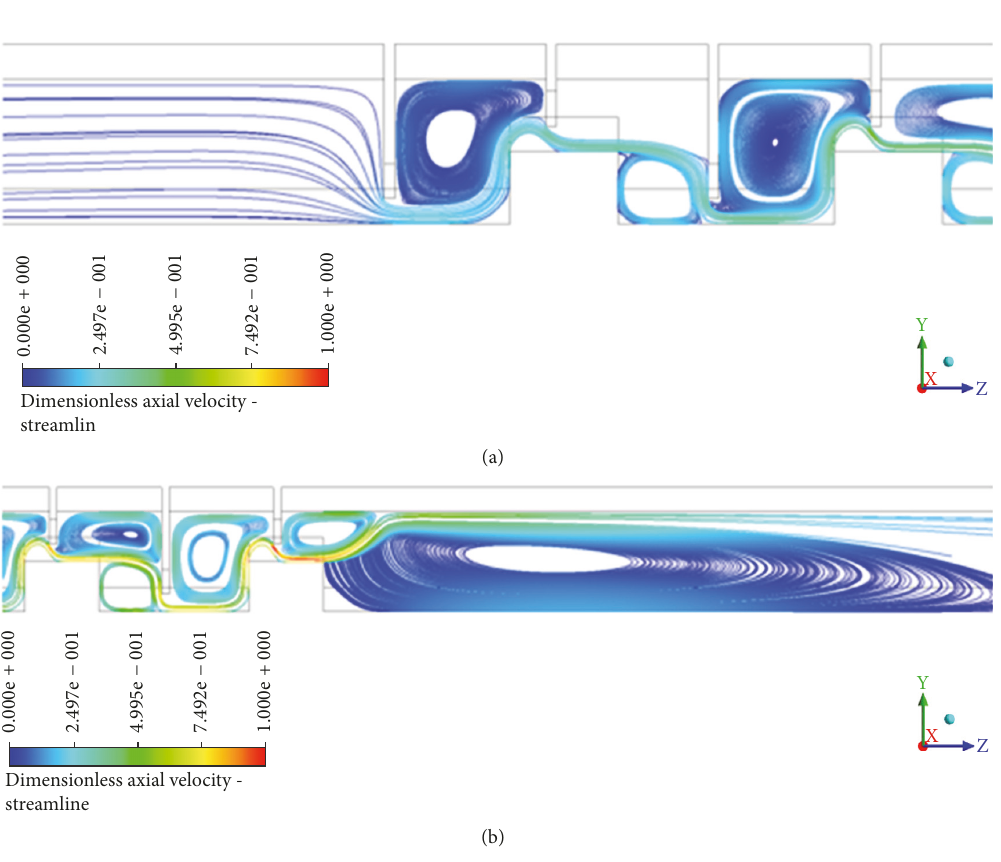
Figure 11: Meridional velocity coloured streamlines at inlet (a) and outlet (b)